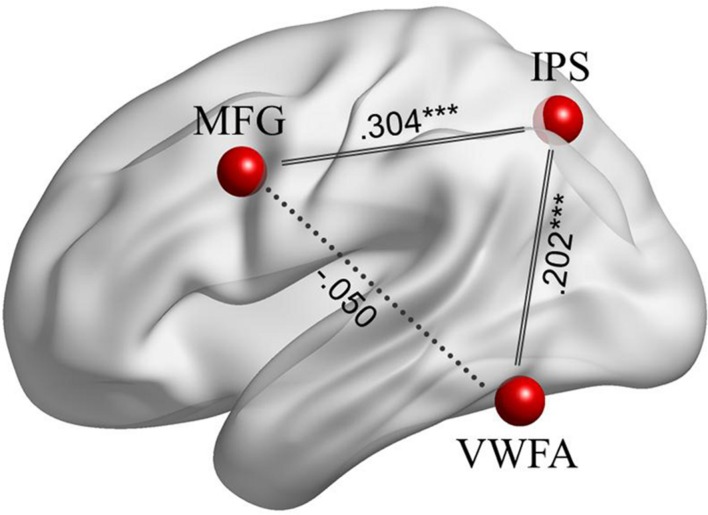
The FCs among the left MFG, left IPS, and VWFA during resting-state fMRI. Significant correlations are at ∗∗∗p < 0.001, indicated by solid lines.